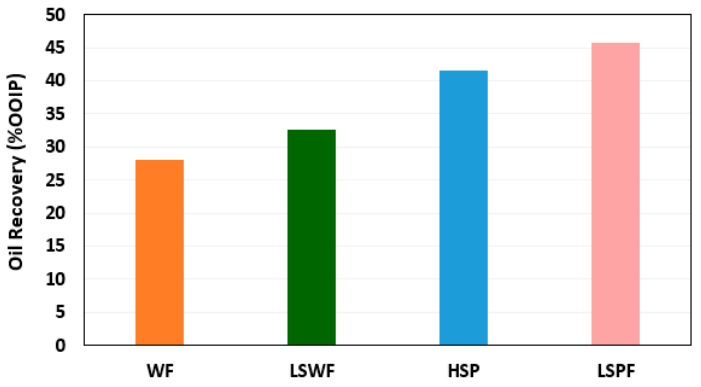
Figure 22. Comparison of LSPF with high-salinity WF (50,000+ ppm), LSWF (2000 ppm), and HSP flooding after 0.6 PV injection [130].